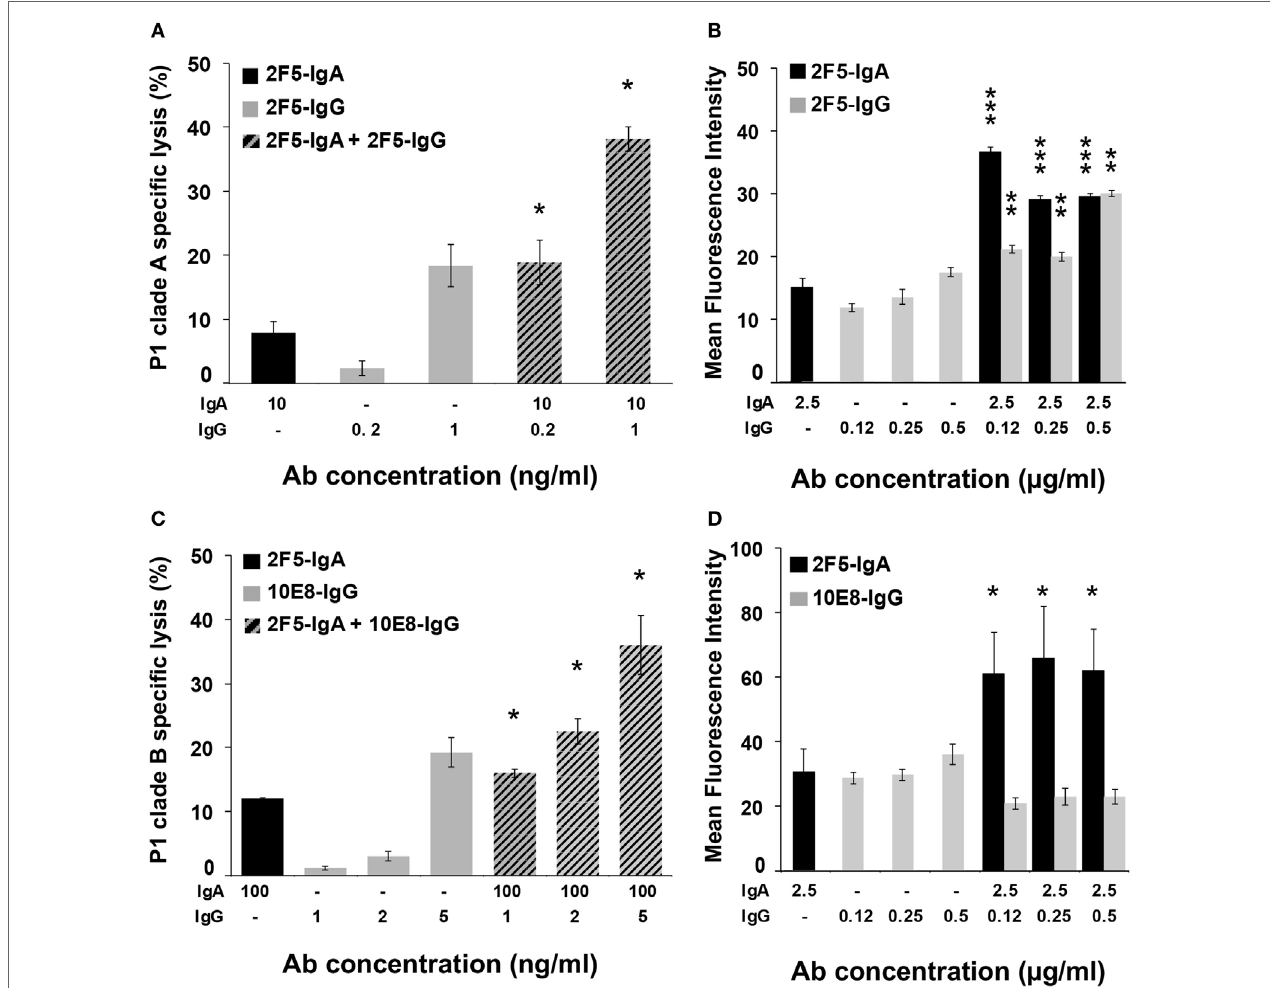
FigUre 5 | 2F5-IgA cooperates with 2F5-IgG to induce lysis of P1-A target cells by antibody-dependent cellular cytotoxicity (ADCC) as a result from increased binding to target cells. (a,c) CD4 + T CEM-NK r cells coated with P1-A and P1-B and double stained with PKH26/carboxyfluorescein diacetate succinimidyl ester were incubated with either 2F5-IgA (black bars), 2F5-IgG or 10E8-IgG (gray bars), or with a combination of both, at indicated concentrations, for 30 min at room temperature (RT). Then, effector cells were added at an effector/target ratio of 10:1. Hatched bars represent the experimental values ± SEM of ADCC induced by the combination of 2F5-IgA and 2F5-IgG or 10E8-IgG at indicated concentrations. n = 3 independent experiments performed in duplicate. * p < 0.05, Student’s t -test between the arithmetical sum of cell lysis induced by each isotype separately and cell lysis induced by both isotype together. (B,D) CD4 + T CEM-NK r cells coated with P1-A and P1-B were incubated with 2F5-IgA (black bars), 2F5-IgG or 10E8-IgG (gray bars), or with a combination of both at indicated concentrations for 1 h at 4°C. Specific binding was detected using either mouse fluorescein isothiocyanate (FITC)-conjugated anti-human IgA or allophycocyanin (APC)-conjugated anti-human IgG, or the combination of both, and analyzed by flow cytometry, as indicated in the Section “Materials and Methods.” Values represent MFI of specific binding. n = 5 independent experiments. *** p < 0.0001 and p < 0.0002, ** p < 0.001, Student’s t -test between MFI values of the binding of IgA or IgG alone with that of IgA or IgG in the combination mix,